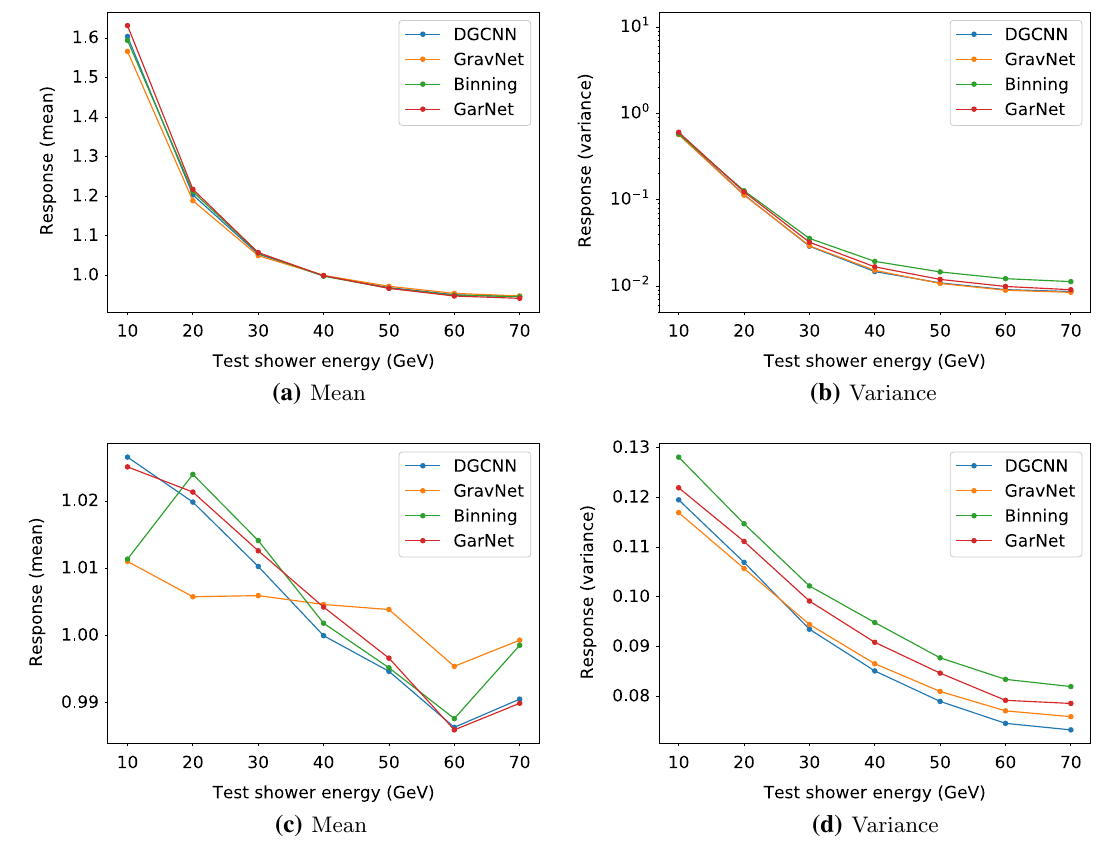
Fig. 4 Mean (left) and variance (right) of the test shower response as a function of the test shower energy for full shower (top) and for overlapping shower (bottom), computed summing the true deposited energy. Swapping of the showers is allowed here